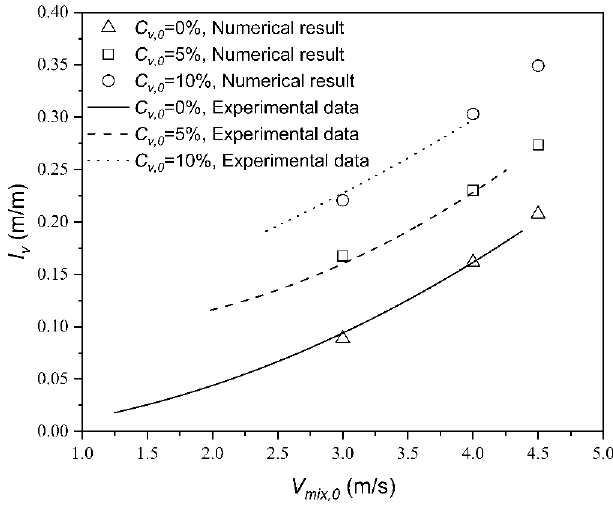
Figure 4. Comparison of total pressure drop between numerical and experimental results.